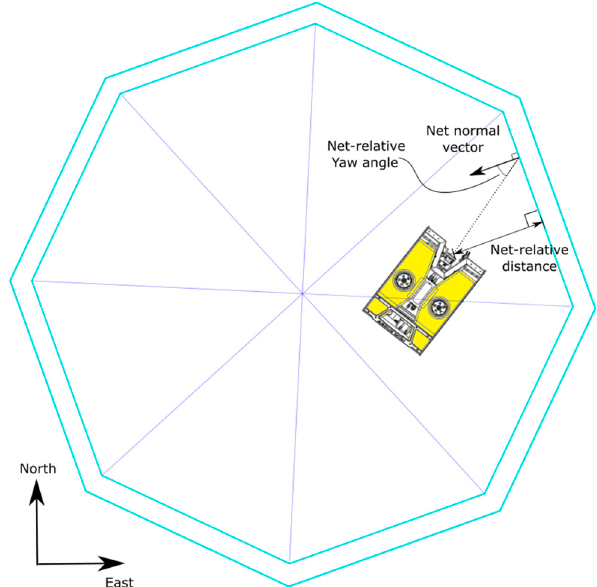
Figure 6. The geometry of the fish cage and the measured net distance and yaw angle in the horizontal North-East plane. The ROV is roll and pitch stable, but the pitch varies ±10 degrees around the zero point, so the horizontal assumption is not perfect. The yaw angle is calculated by projecting into the North-East